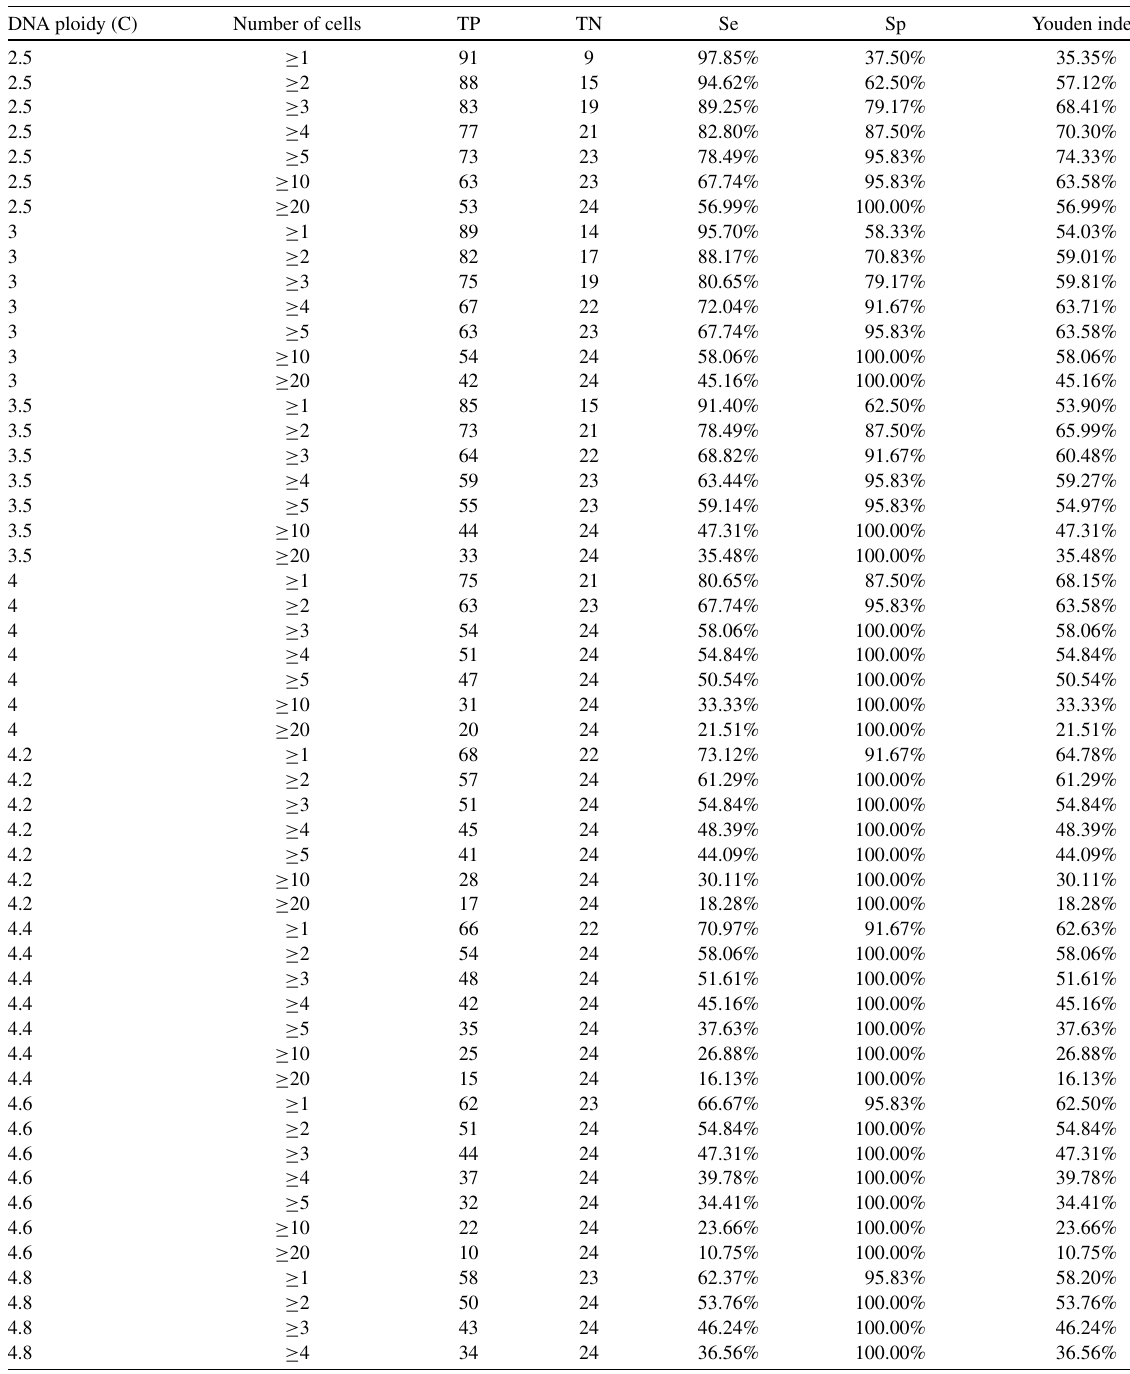
Sensitivity, specificity and Youden Index of cytologic diagnosis of effusion by DNA ploidy using different DNA ploidy parameters obtained from automated DNA-image cytometry DNA ploidy